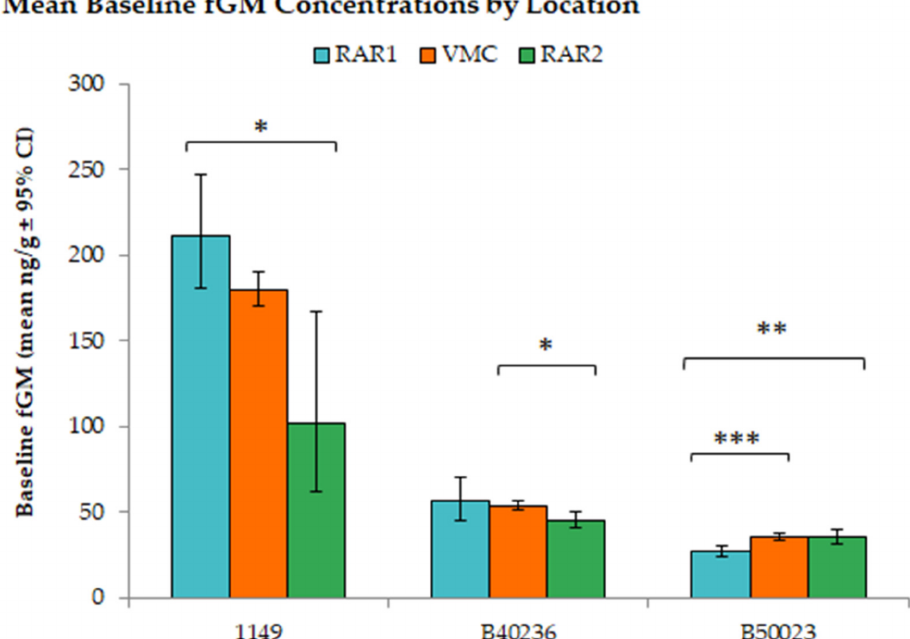
Figure 3. Average baseline fGM concentrations (ng/g) by location and individual. A type I, two-way ANOVA with a Games–Howell post-hoc analysis showed multiple significant differences. * p -value < 0.05; ** p -value < 0.01; and *** p -value <